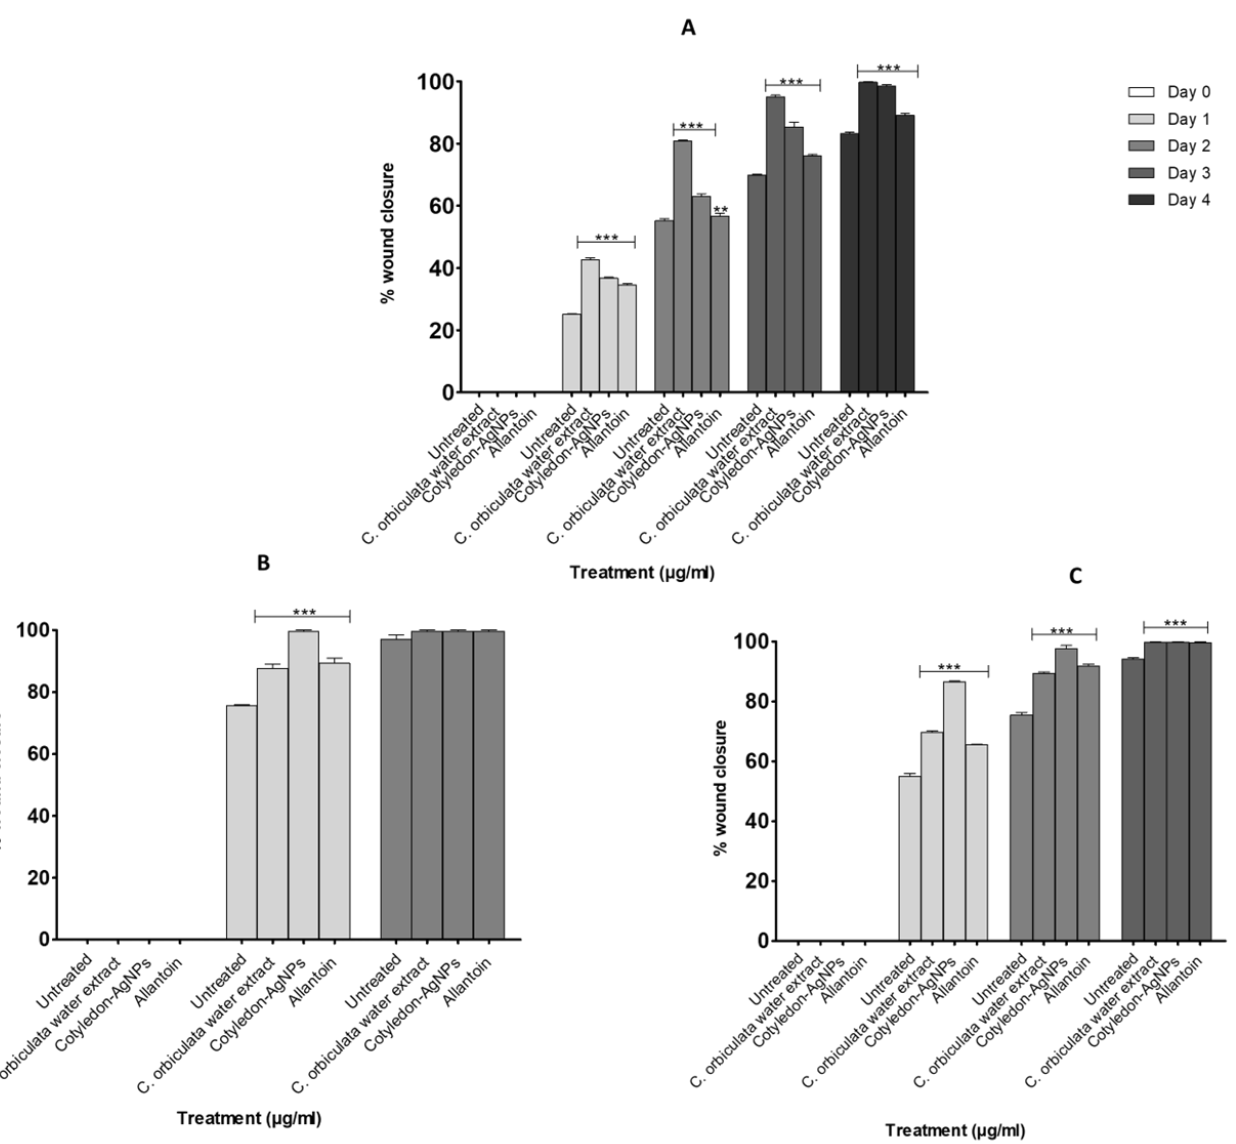
Figure 3. Percentage wound closure rates of Cotyledon -AgNPs and C. orbiculata water extract-treated KMST-6 ( A ), HaCaT ( B ) and CHO ( C ) cells. Each value represents mean ± standard error of the mean (SEM); statistical significance was indicated with ** p for < 0.01 and *** p <